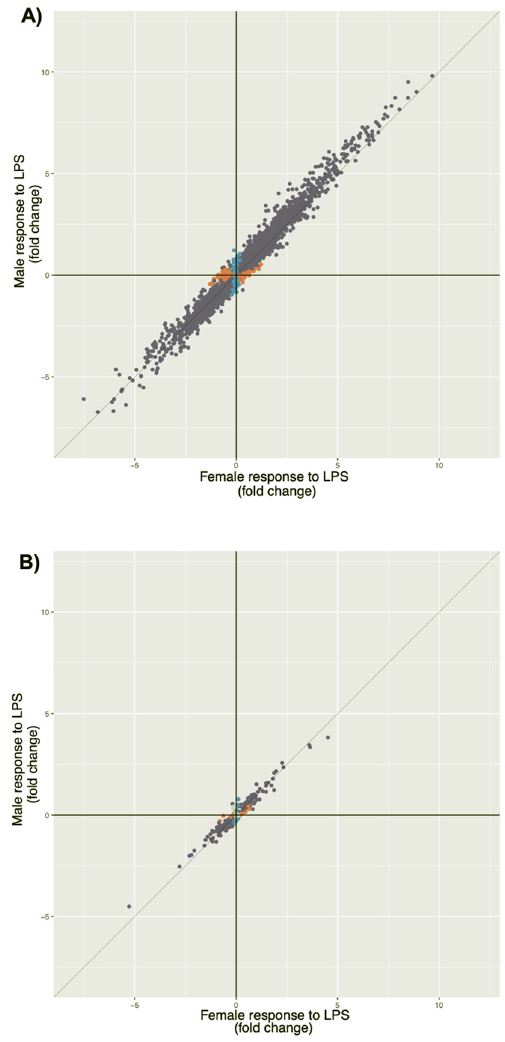
Figure 3. Scatterplot of fold change responses to LPS of genes located on ( A ) the autosomes (N = 12,475) and ( B ) the X chromosome (N = 393). Only genes with significant responses are shown. At FDR < 0.05, genes colored in blue were observed only in males, genes colored in orange were observed only females, and genes colored in purple were observed in both